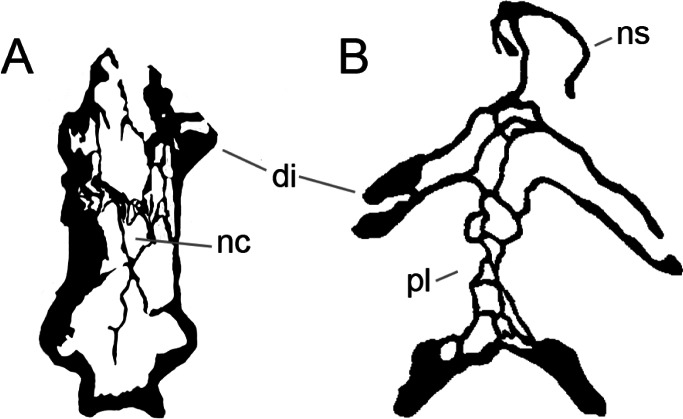
Cross-section of neosauropod cervical vertebrae.Mid- to posterior cervical vertebrae cross-section of Supersaurus vivianae WDC DMJ-021 (A; modified from Lovelace, Hartman & Wahl, 2007), and Brachiosaurus sp. BYU 12866 (B; modified from Wedel, 2009). Sections at base of diapophysis. Note the different internal pneumatic structure, with few but large cavities in Supersaurus (A; C130-1), in contrast to the many irregularly small fossa typical for titanosauriforms (B; C130-2). The differences shown here in cervical vertebrae apply as well for dorsal vertebrae (C228). Pictures scaled to the same centrum height. Abb: di, diapophysis; nc, neural canal; ns, neural spine; pl, pleurocoel.